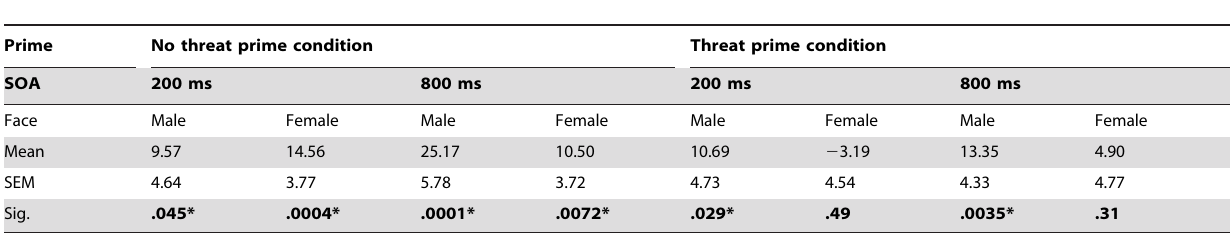
Table 3. Descriptive statistics of the gaze cue effect (RT invalid- RT valid in ms) and results of one-sample t-tests (tested against 0, no difference RT valid vs. invalid